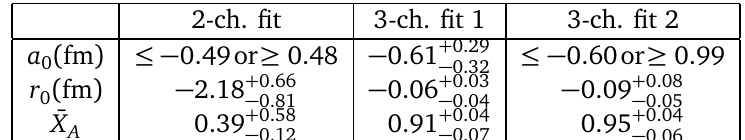
Table 3: The effective range parameters in the J /ψ J /ψ channel and the composite- ness ¯ X of the proposed X ( 6200 ) A